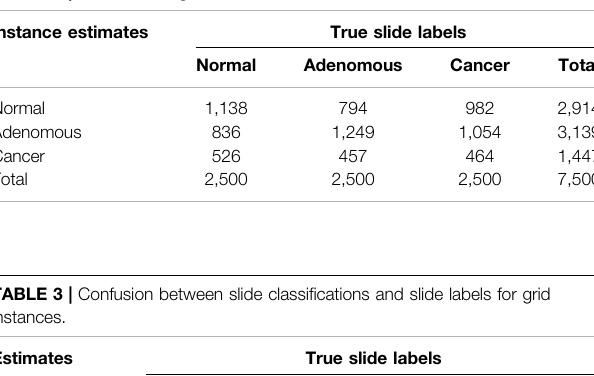
TABLE 2 | Confusion of grid instances between classi fi cations and slide labels.